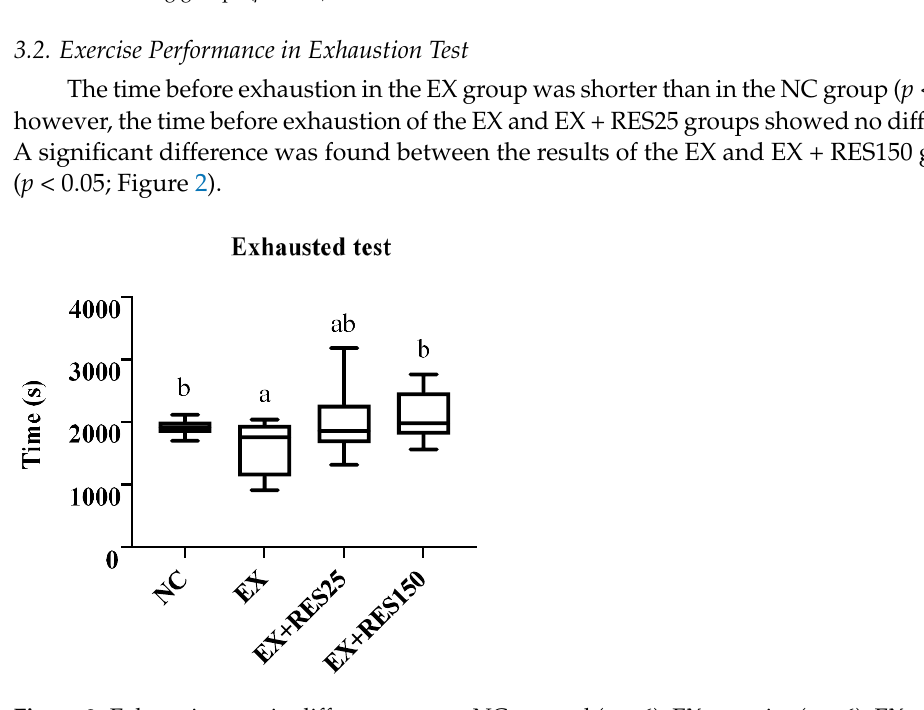
Figure 2. Exhaustion test in different groups. NC: control ( n = 6); EX: exercise ( n = 6); EX + RES25: exercise with resveratrol 25 mg/kg ( n = 6); EX + RES150: exercise with resveratrol 150 mg/kg ( n = 6). Data are presented as mean ± SEM. Data were analysed using one-way analysis of variance and a t -test followed by the Bonferroni multiple comparison test. Superscript letters (a and b) in columns denote a significant difference ( p <